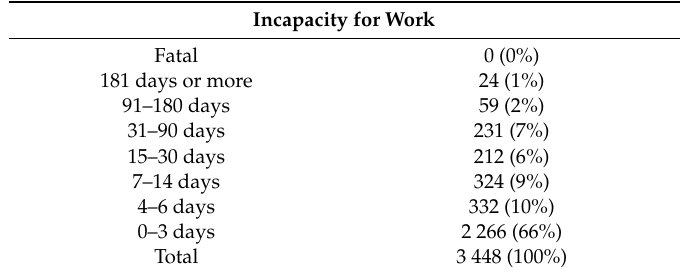
Table 3. The numbers and shares of days of incapacity for work.